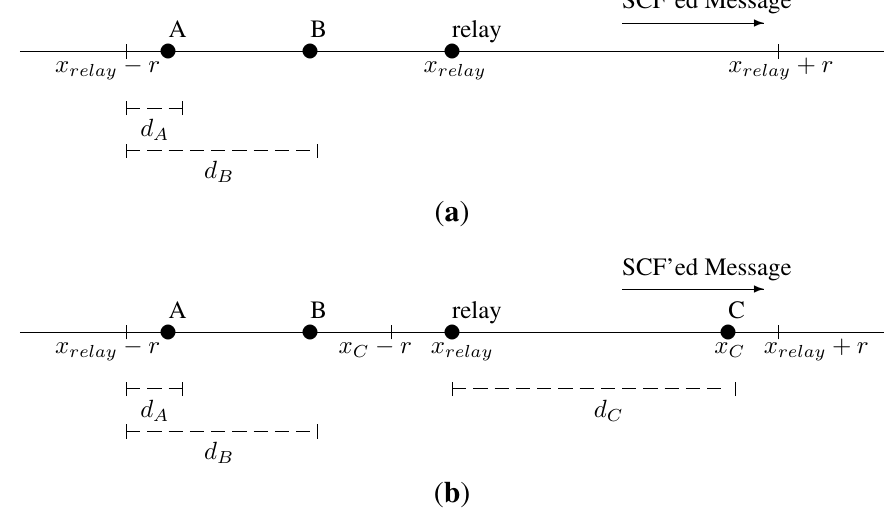
Figure 8. Relay detection in the range [ x as a new relay; ( b ) B and C are both selected as new relays. The previous relay must repeat the message from C, so that B can hear